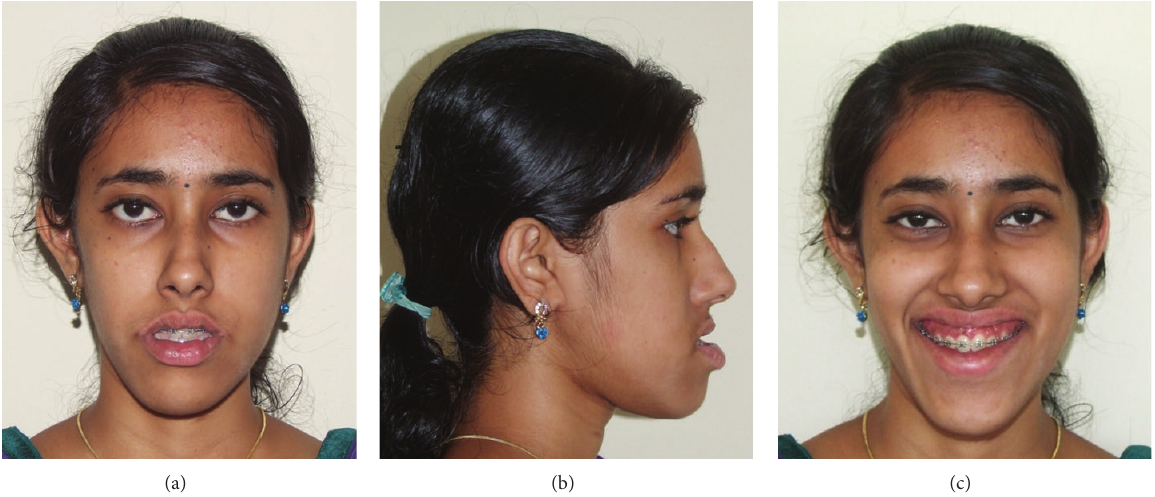
Figure 7: Presurgical face: (a) frontal, (b) profile, and (c) smile.